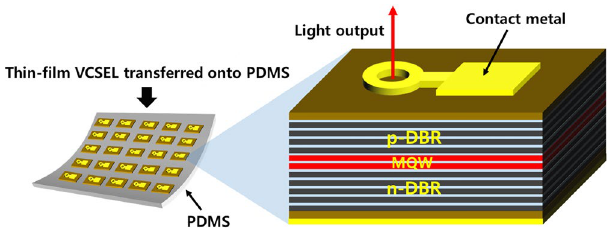
Figure 1. Schematic structure of the thin-film vertical-cavity surface-emitting laser (VCSEL) transferred onto a PDMS substrate. The top-emitting thin-film VCSEL was successfully fabricated onto the PDMS substrate by using a double-transfer technique in conjunction with the surface-modification bonding (SMB) process.